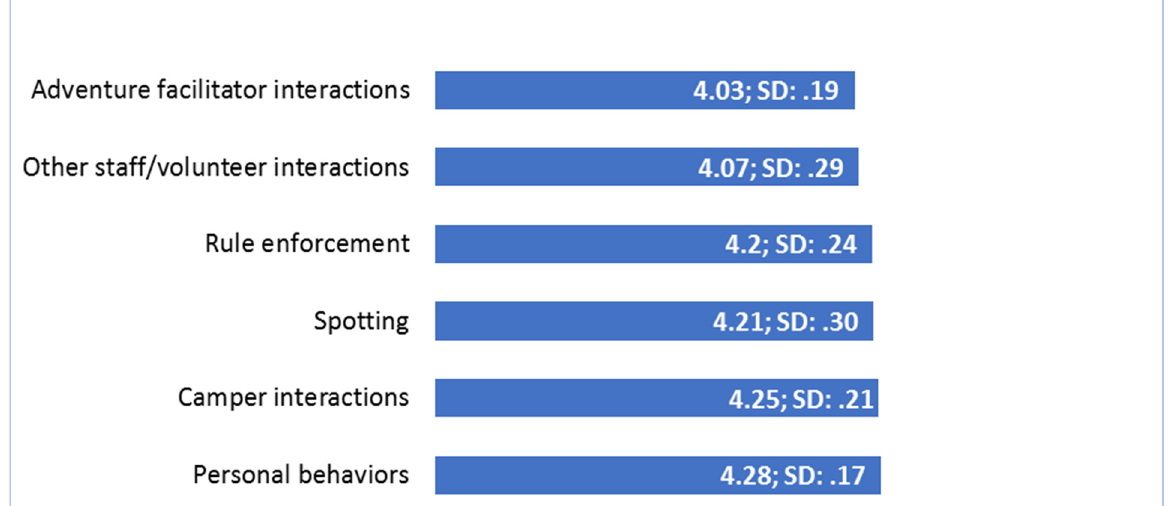
Figure 2. Average Scores for Staff Engagement Rubric